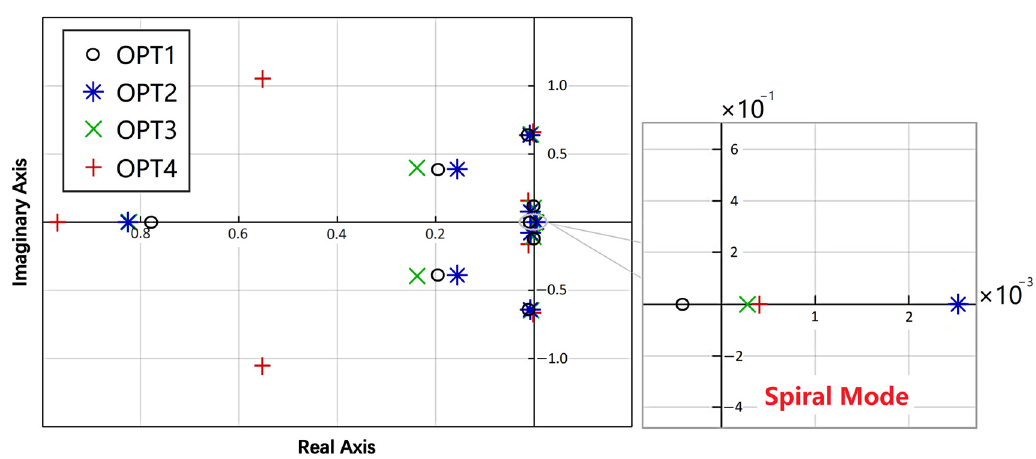
Figure 13. Poles of aircraft dynamics for landing status of four configurations.